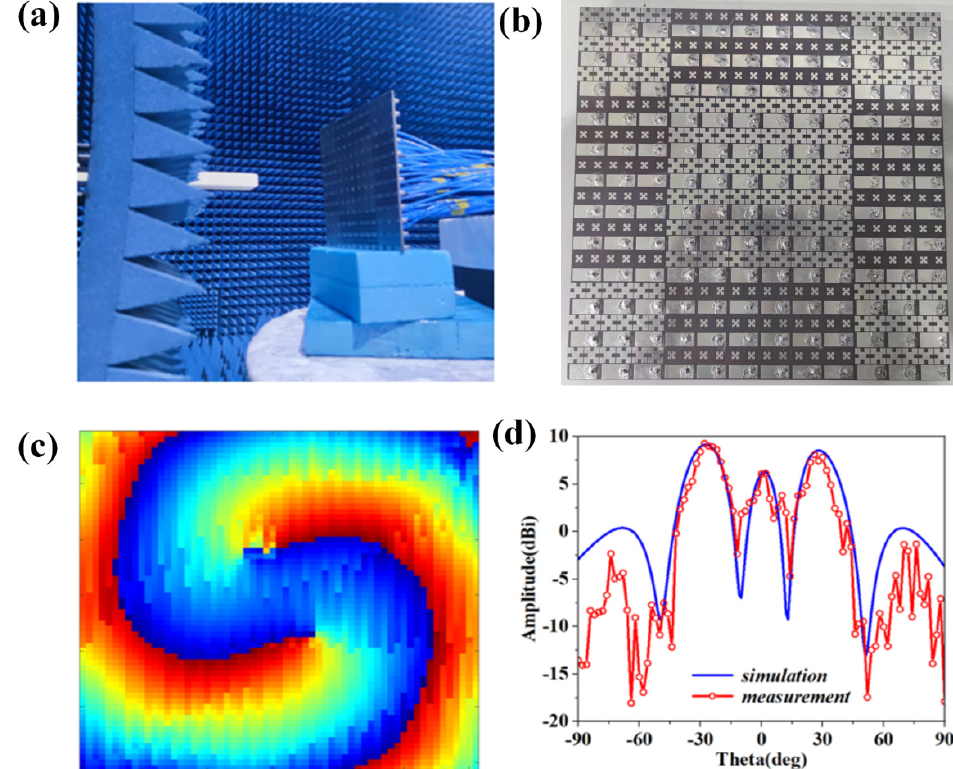
Figure 9. Environment of the measurement for near-field and measured results. ( a ) Environment of the measurement for the CFMS. ( b ) Prototype of the CFMS. ( c ) Measured phase distribution of OAM with − 2 mode on the plane. ( d ) OAM radiation patterns in xoz-plane.